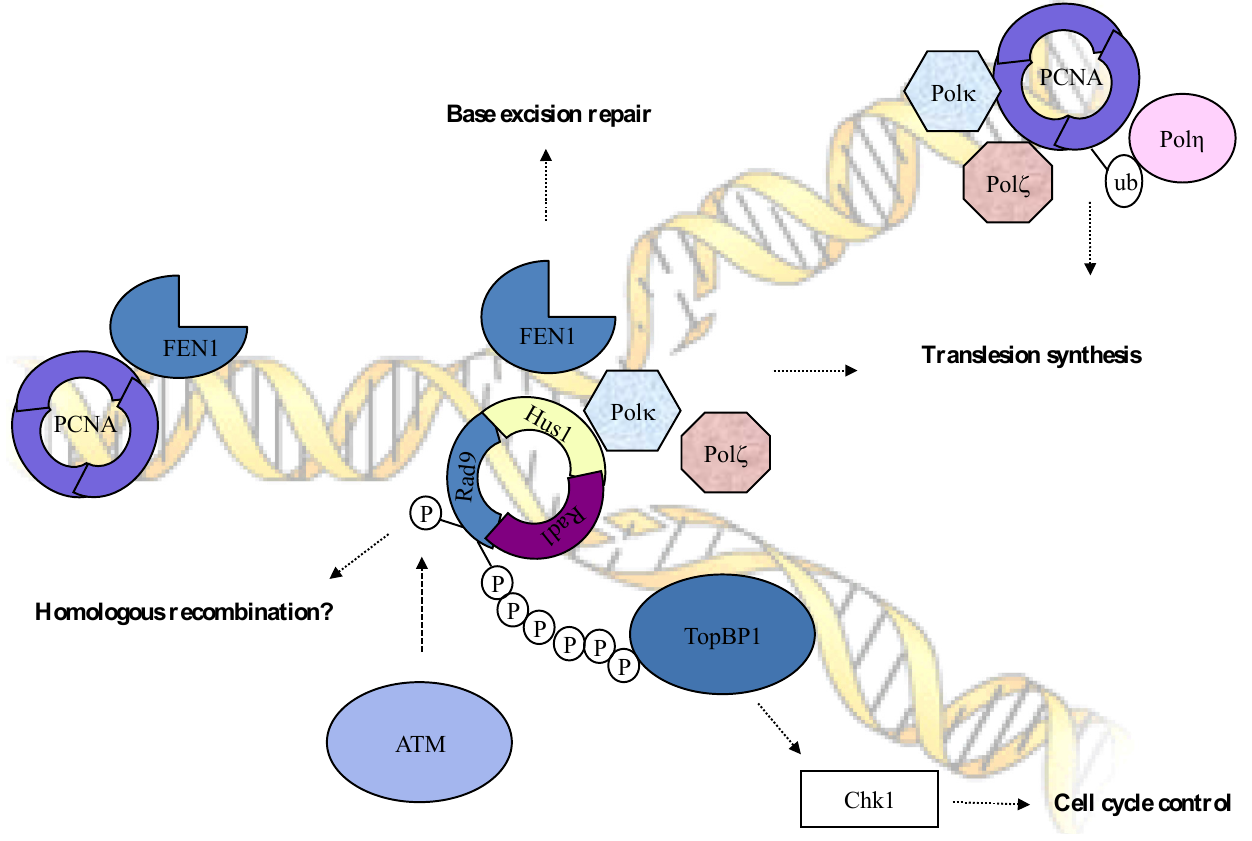
Figure 1. The checkpoint clamp (Rad9-Husl-Radl) complex plays various roles in DNA damage response pathways. The C -terminal tail of Rad9 is required for Chk1 activation through interaction with TopBP1. In addition to the role in checkpoint activation, the checkpoint clamp functions in multiple DNA repair pathways such as translesion synthesis and base excision